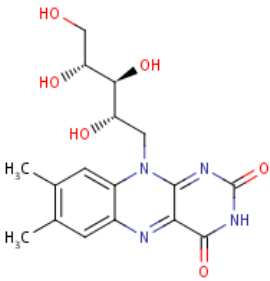
Figure 9. Pantothenic acid structure.